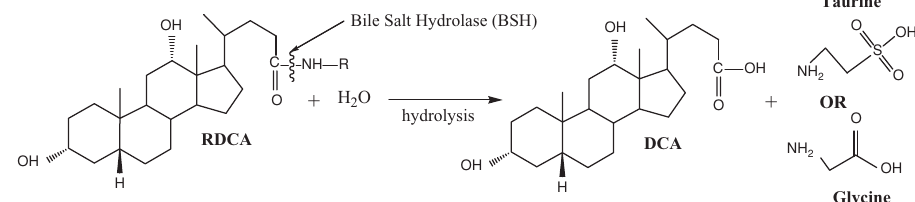
Figure 6 Hydrolysis of conjugated bile salts by the bile salt hydrolase (BSH) enzyme overproduced by genetically engineered Lactobacillus plantarum 80 (pCBH1) (10). R indicates the amino acid glycine or taurine. RDCA: glyco- or tauro-deoxycholic acid, DCA: deoxycholic